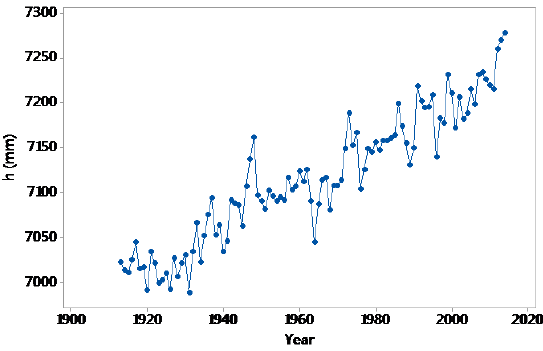
Figure 1: Yearly averaged sea level records at Key West (Florida, USA) tide gauge